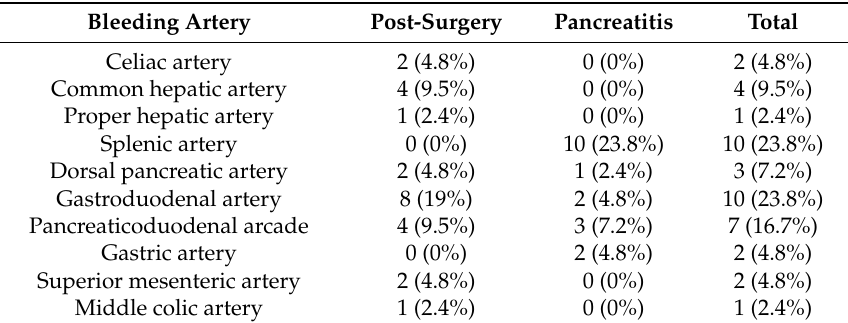
Table 3. Distribution of artery origins of